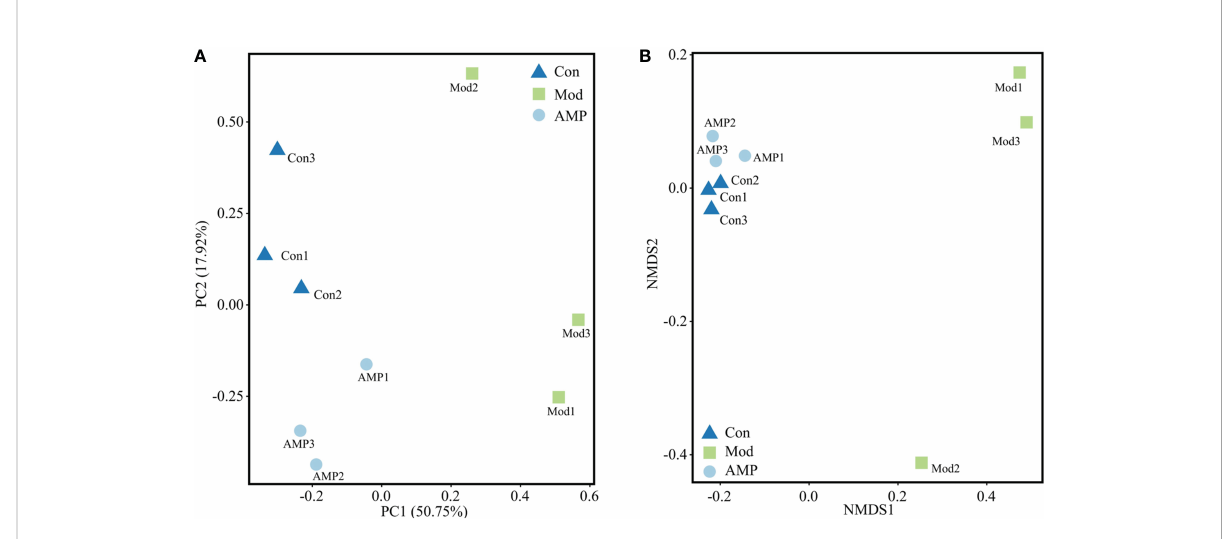
FIGURE 5 Effect of AMP on intestinal beta diversity of MGH rats (A) , PCA; (B) ,